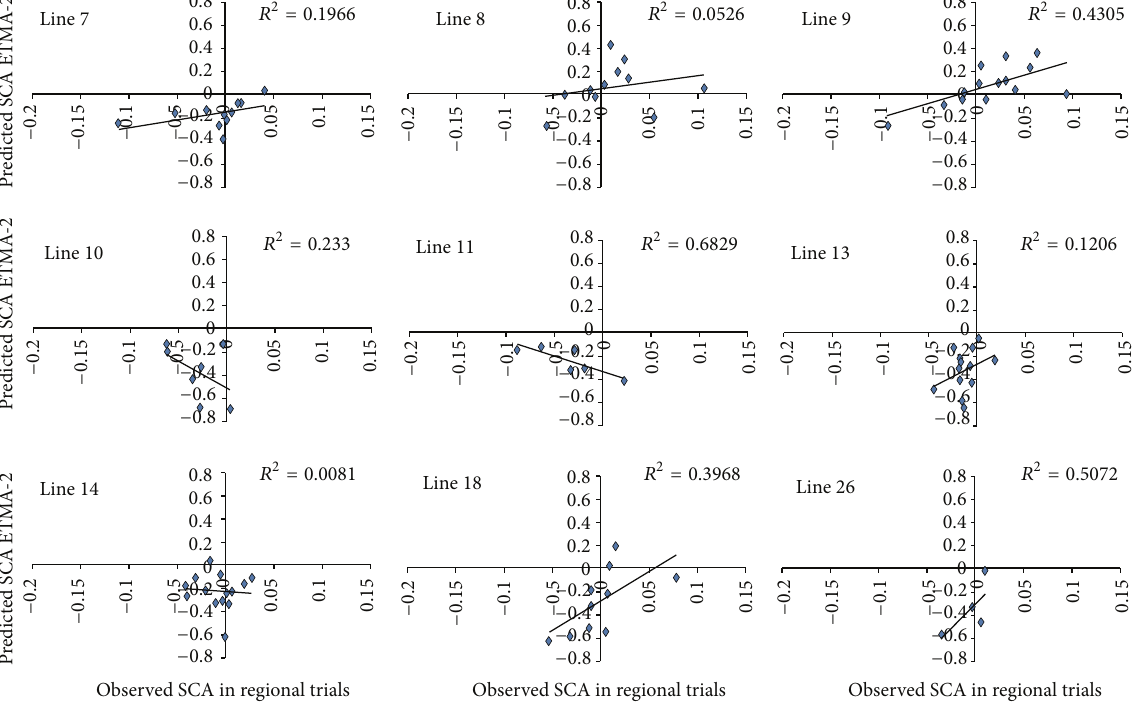
Figure 5: Total effects of associated markers (TEAM2) method fit per line with more than 4 crossing replicates (lines 7, 8, 9, 10, 11, 13, 14, 18, and